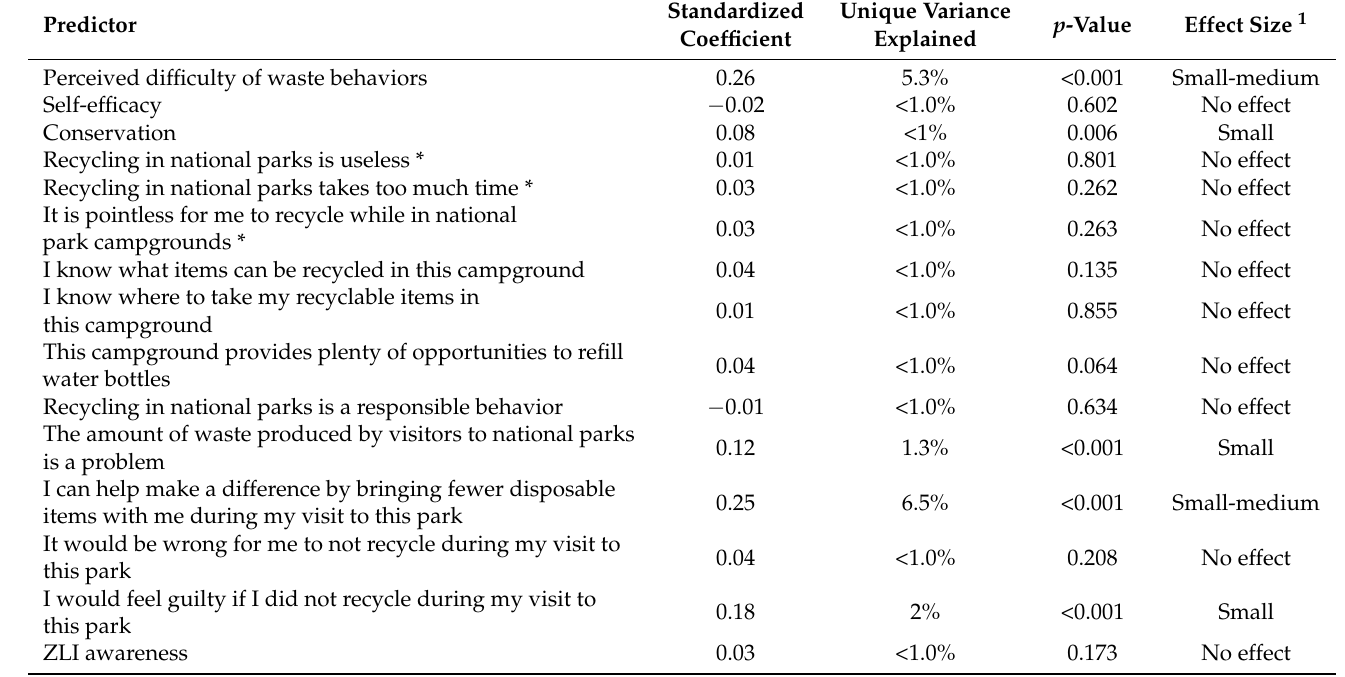
Table 4. Multiple Regression Explaining Self-reported Waste Behavioral